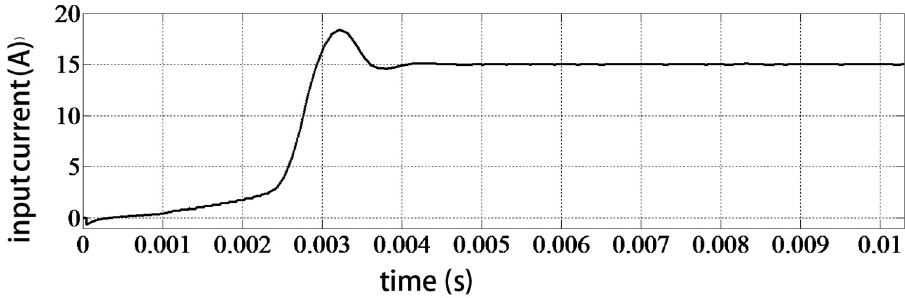
Figure 5. The input-current-tracking algorithm Simulink simulation results after correction.